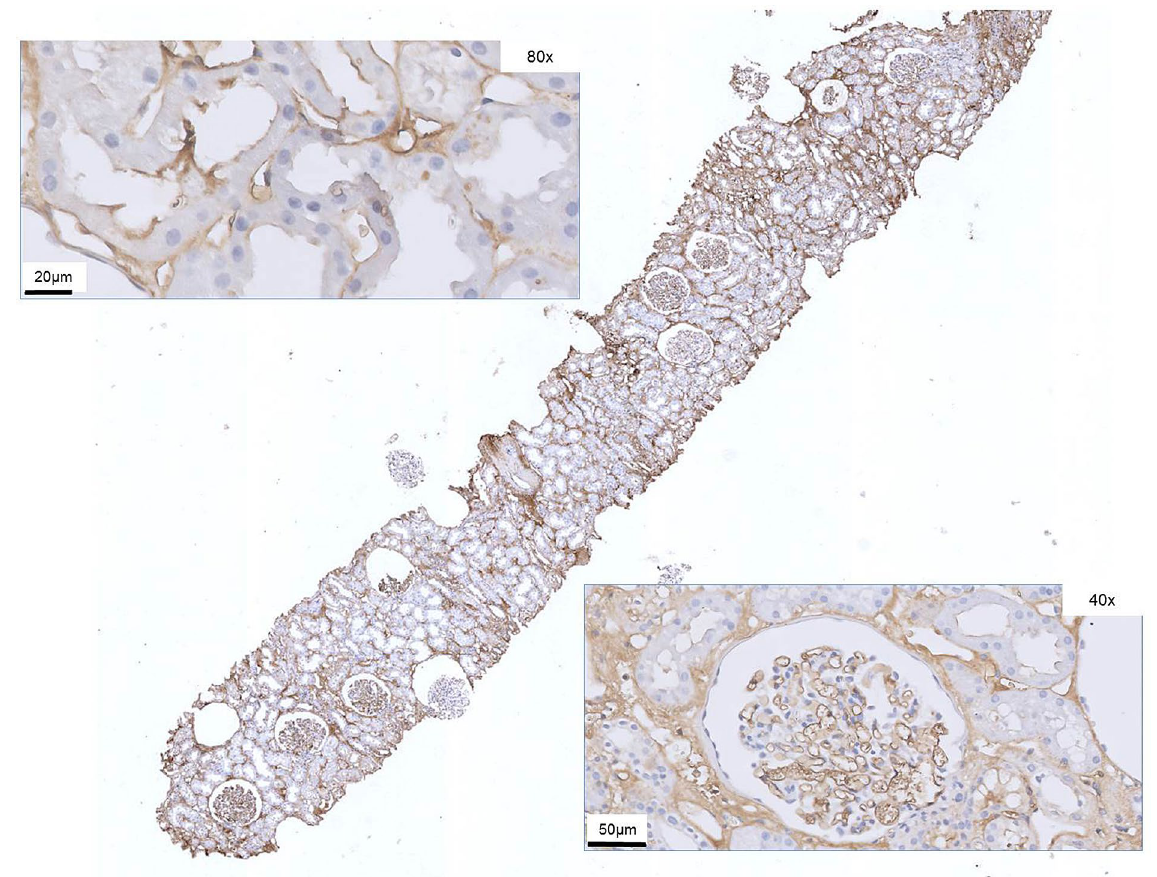
Figure 3. Kidney biopsy core (IHC stain with antibody against fibrin). Magnified peritubular capillaries with staining of endothelial cells (top left) and magnified glomerulus with generalized deposition of fibrin on endothelial lining (bottom right).